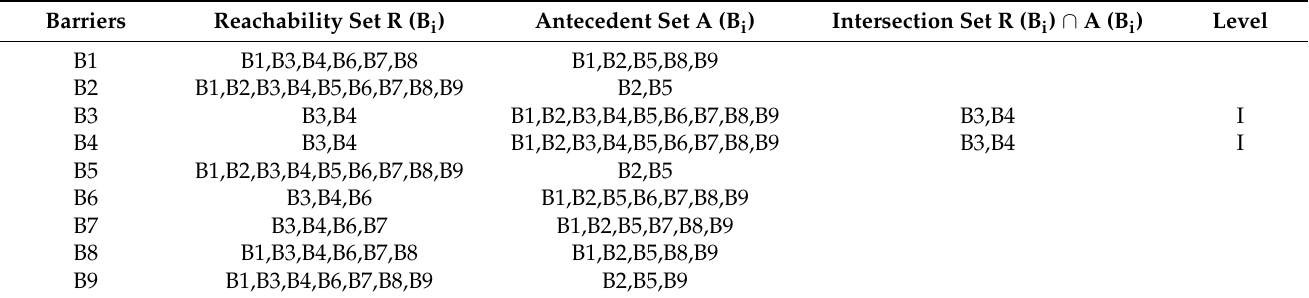
Table A1. Level partition iteration